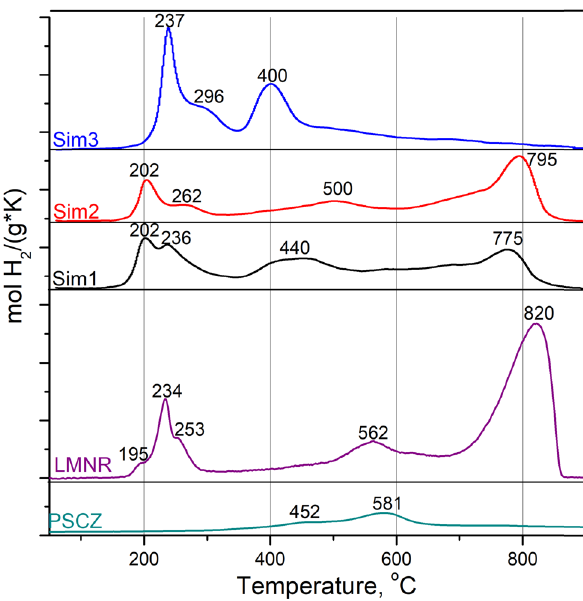
Figure 5: The TPR - H 2 pro fi les of the LMNR and PSCZ, Sim1, Sim2 and Sim3